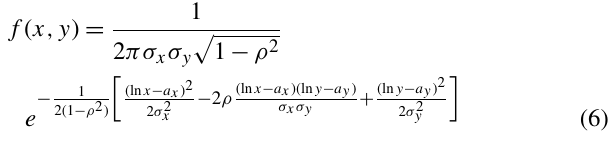
and y , and the mean quadratic error < σ y ; and if ρ = 0, then the mean quadratic error = σ y . The higher the correlation be- tween x and y , the smaller the mean quadratic error of prob- ability distribution of y is. The Log normal distribution of x and y should be formulated, then a x , σ x , a y , σ y can be obtained, the correlation coefficient ρ can be computed, and parameters of conditional distribution of y can be fixed. Figure 4 gives the cumulative Log normal distribution of the discharge on 30 June, at the Haerbin station in Songhua river in northeast China, whose basin area is 557 200 km 2 . Figure 5 provides the comparison of condi- tional and non-conditional cumulative log normal distribu- tions of the monthly discharge of July, at the Haerbin station, where, the mean quadratic error of conditional distribution is less than that of the non-conditional distribution. Observed and predicted monthly discharge of July 1999, at the Haerbin station are shown in Table